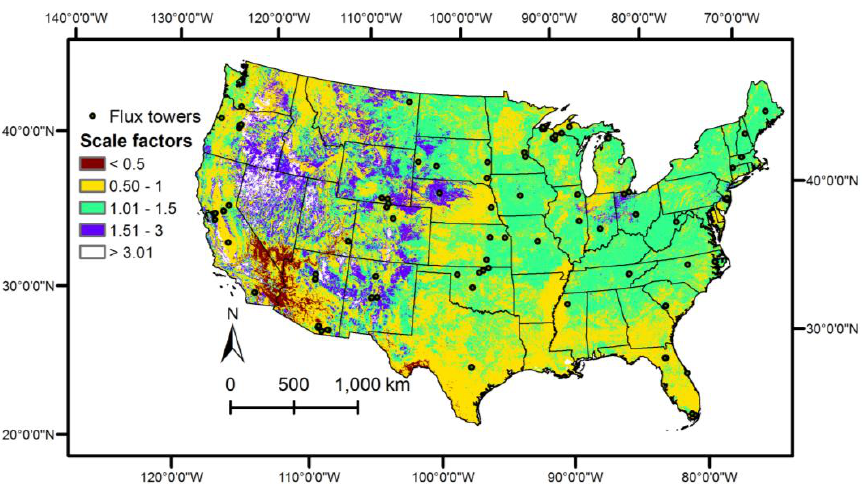
Figure 7. Scale factor map used in converting SSEBop ET estimates to SSEBop/Water-Balance (SSEBop-WB) ET estimates. Locations of AmeriFlux towers are also shown. This map represents the ratio of the long-term EWB ET (Figure 1a) to the long-term SSEBop ET (Figure 3a), except in irrigated areas where the scale factor values are set to